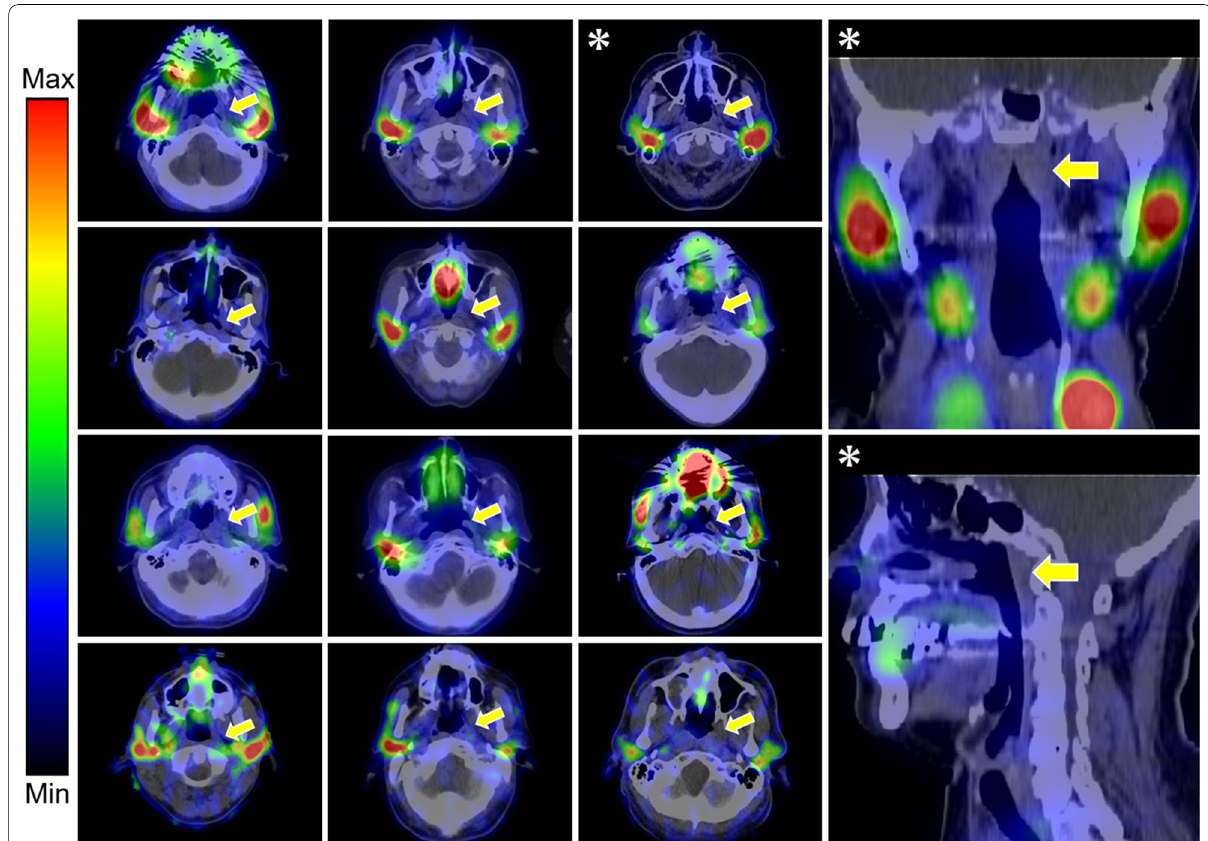
Fig. 1 [ 99m Tc]pertechnetate SPECT/CT images of all the patients. Yellow arrows show the torus tubarius. Images marked with asterisks belong to the same